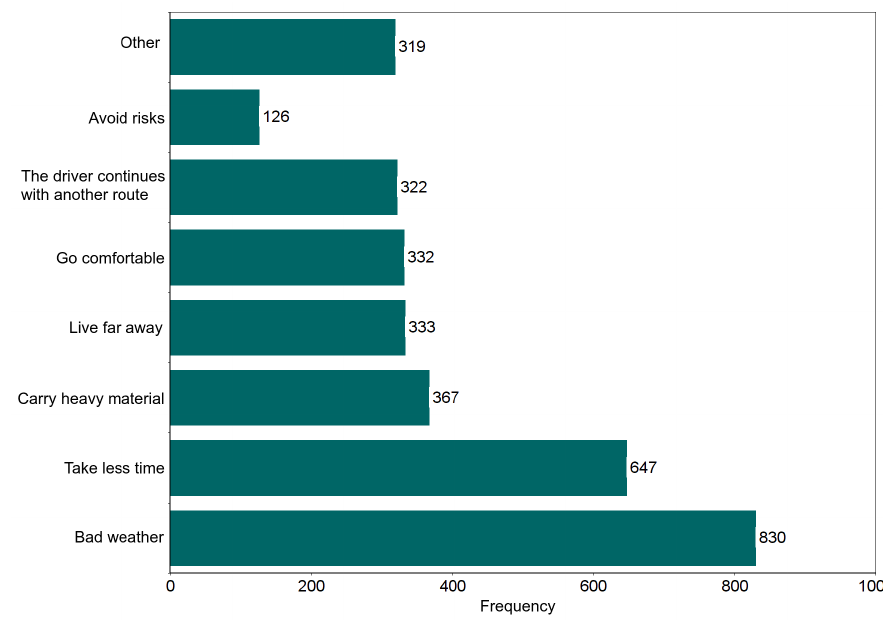
Figure 8. Student’s preferred mode of transportation.